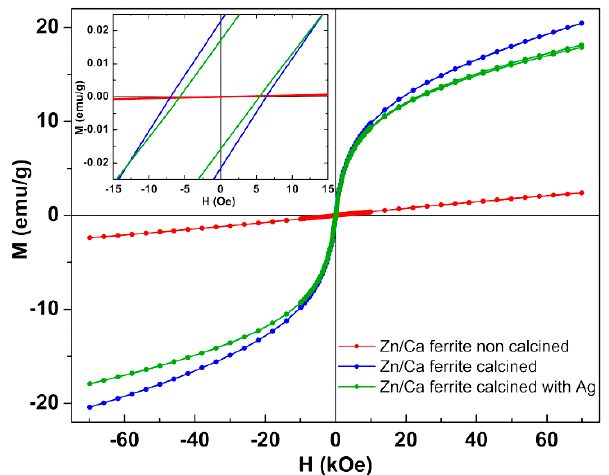
Figure 5. Magnetization hysteresis loop of zinc / calcium ferrite nanoparticles (non-calcined and calcined) and zinc / calcium ferrite nanoparticles coated with silver at room temperature. Inset: Enlargement of the loop in the low field region. Table 4. C oercive field (H c ), saturation magnetization (M s ), remnant magnetization (M r ) and ratio M r /M s for zinc/calcium ferrites at room temperature.